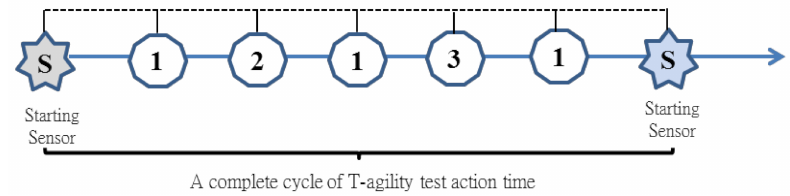
Figure 5. Agility measurement procedure for self-administered T-shape footwork drills.